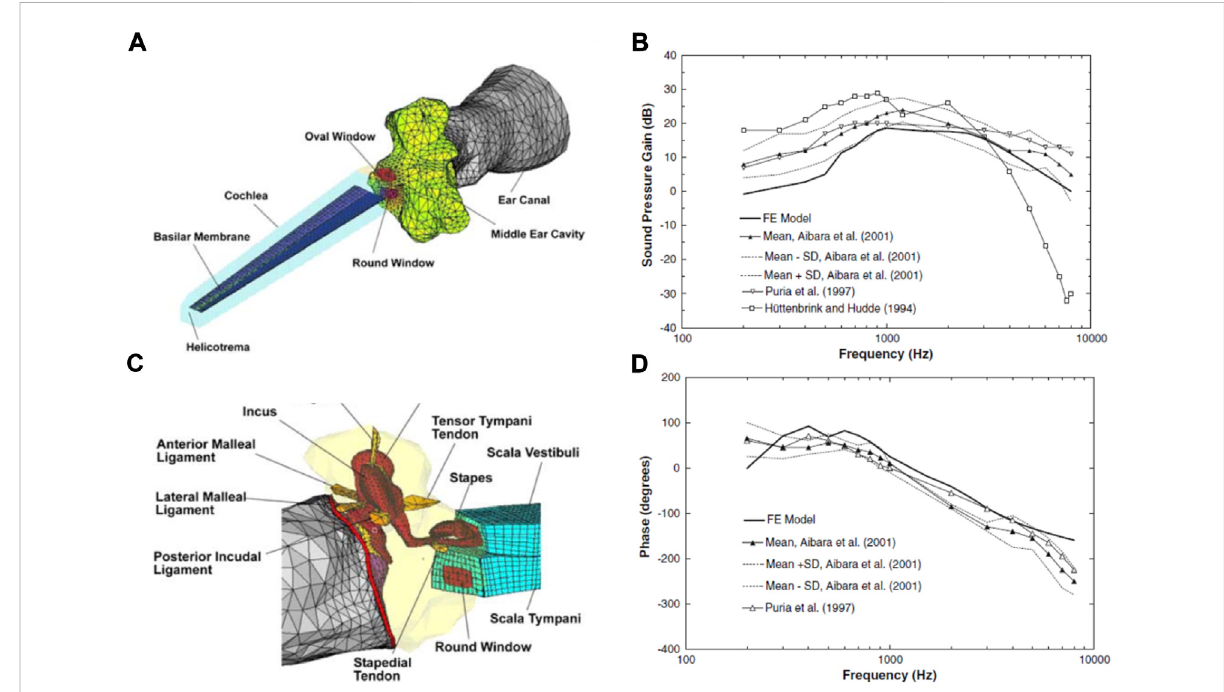
FIGURE 10 (A) Finiteelementmodel(FEM)ofthemiddleandinnerear.DevelopedbyGanetal.(2007b). (B) Connectionofthemiddleearwiththeinnerear. Model derived pressure gain of Gan et al. (2007b) comparedwith others in the literature, showing (C) magnitude and (D) phase angle. Modi fi ed from Gan et al.